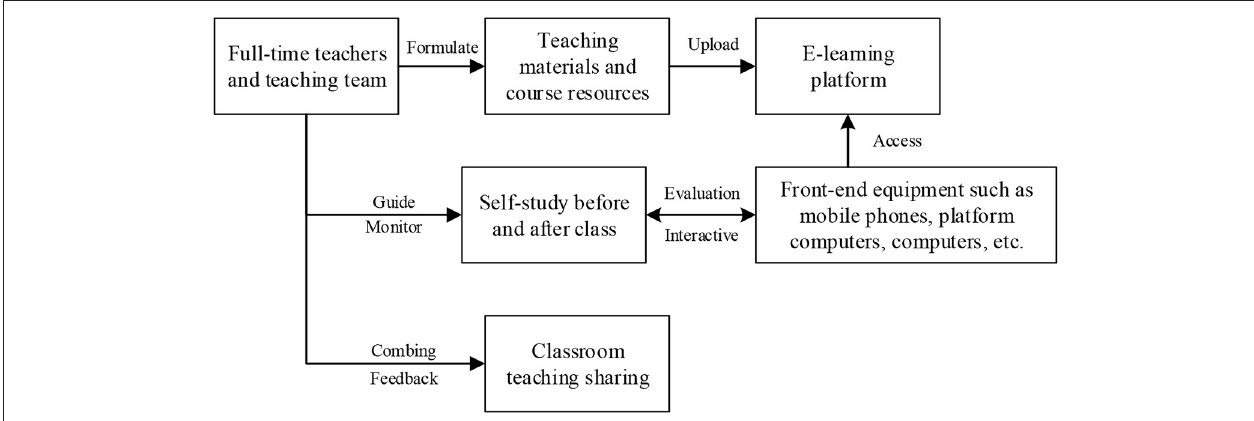
FIGURE 2 | Architecture of the cloud intelligent